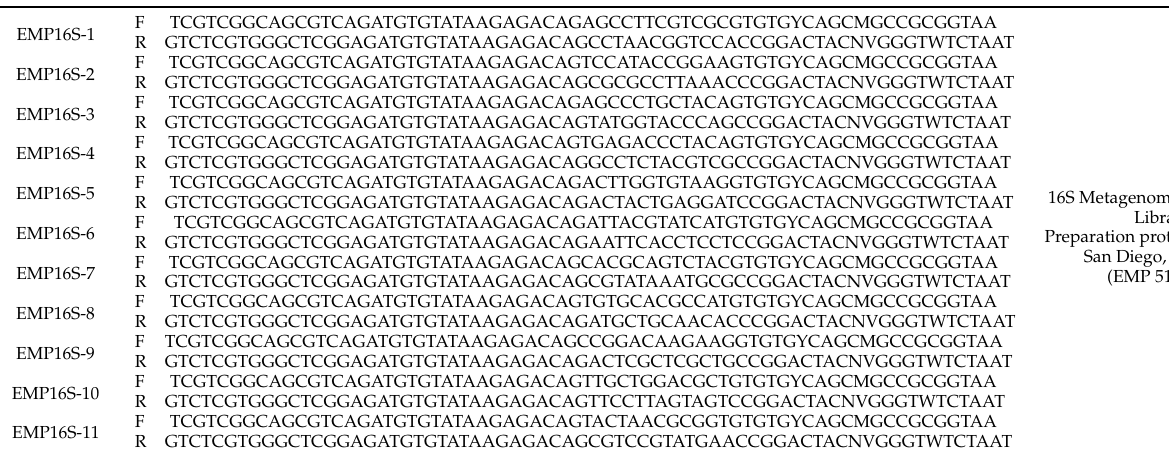
Table 1. List of